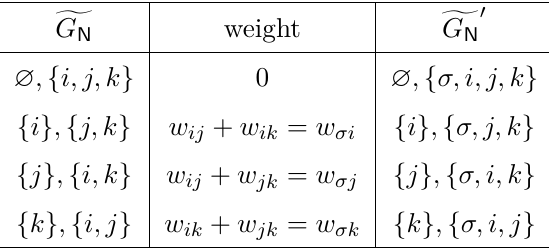
Table 2. Weight contributions to general candidate min-cuts on f G N and f G N which subset of the vertices involved in the graph operation in fig. 17 is included. The agreement between the two graphs proves lemma